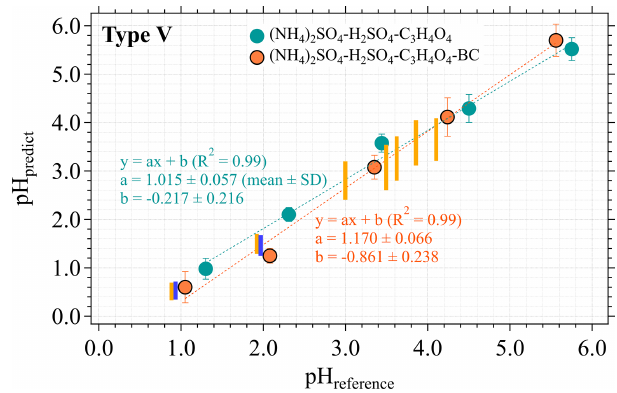
Figure 5. pH estimation using the type V pH paper for lab- generated aerosols with or without the co-existence of black carbon (BC). pH predict is calculated with the averaged coefficient vector [ a , b , c ] derived from five replicate calibration experiments with standard-buffer-generated aerosol samples. The error bars represent the SD of three replicate experiments. The heights of the orange and blue bars indicate the reported pH ranges measured with pH papers and Raman spectroscopy, respectively, for ( NH 4 ) 2 SO 4 − H 2 SO 4 aerosols with particle sizes in the range of 0.4–2.5µm in Craig et al. (2018). At pH reference < 2 . 5, each orange or blue bar has the same pH reference as the orange symbol close to it. Image processing of the collected aerosol samples follows a similar procedure as described in Sect.